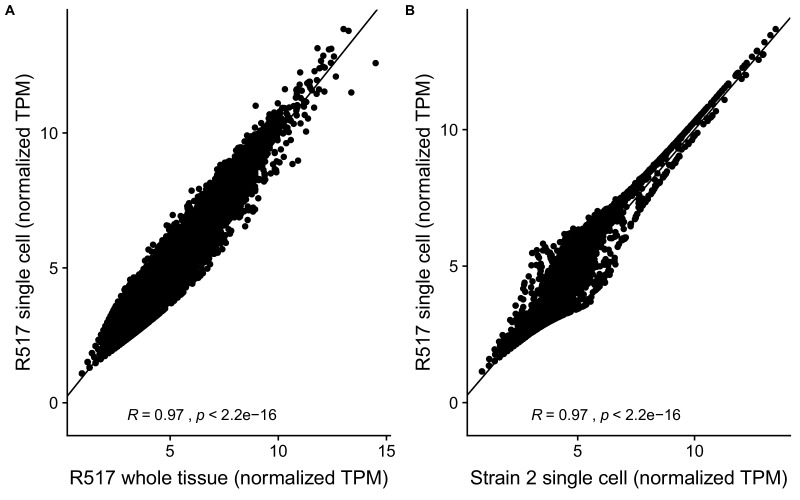
Reproducibility of RAL517 single-cell sequencing data.(A) Correlation between DESeq2 regularized log-transformed TPM (transcripts per million) of genes in 517 whole-tissue RNA-seq data and our single-cell RNA-seq data. Despite different library strategies and sequencing methods our data correlate extremely well with whole-tissue RNA-seq data indicating that our dataset has captured an accurate sampling of testis-expressed genes and our results are reproducible. (B) Correlation between our RAL517 single-cell library and a library of a wild D. melanogaster strain from our lab. Despite being from different strains, the libraries show a high correlation in normalized TPM. This result shows, however, that many genes vary between D. melanogaster strains, necessitating further work to understand transcriptome evolution on a single-cell level.